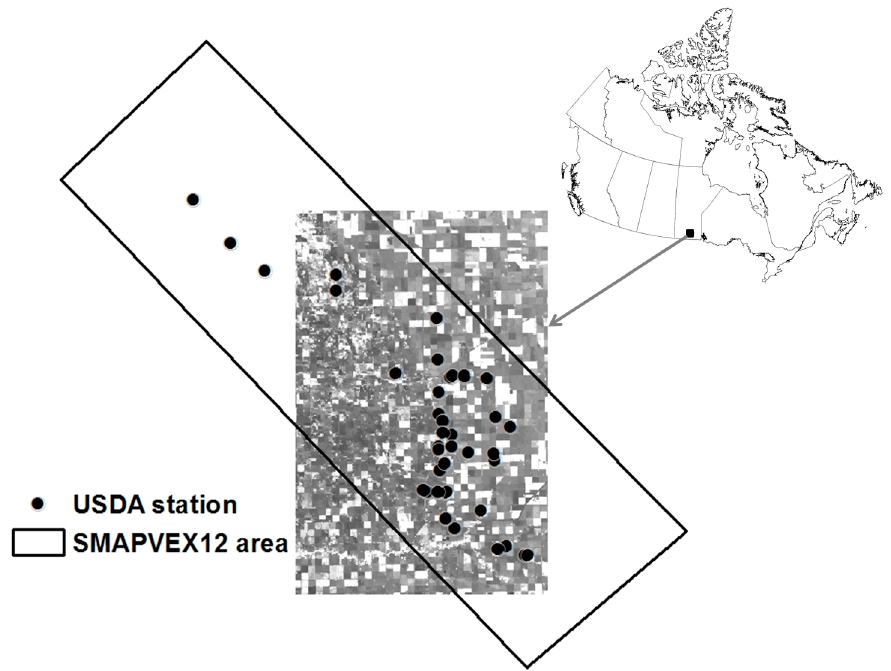
Figure 1. The location of the study area.